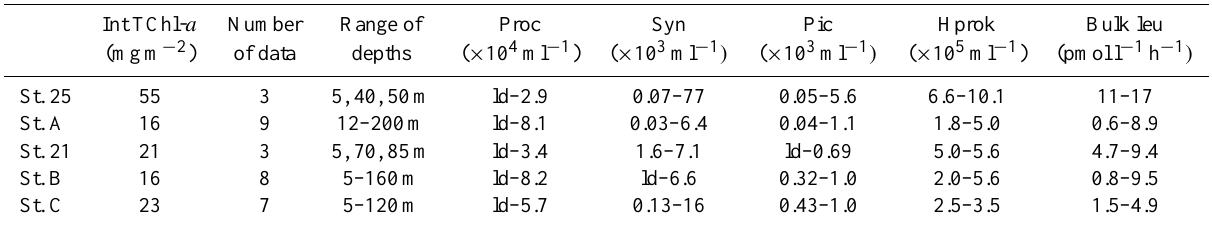
Table 1. Characterics of the biological parameters at the 5 stations. Integrated Total Chlorophyll- a (Int TChl- a : 0–150m), number of depths sampled for flow sorting, ranges of layers sampled, and ranges of abundances and bulk leucine incorporation rates (bulk-leu) correspond- ing. Proc = Prochlorococcus , Syn = Synechococcus , Pic = pico+nano-phytoeukaryotes, Hprok = heterotrophic prokaryotes, ld: limit of detection.